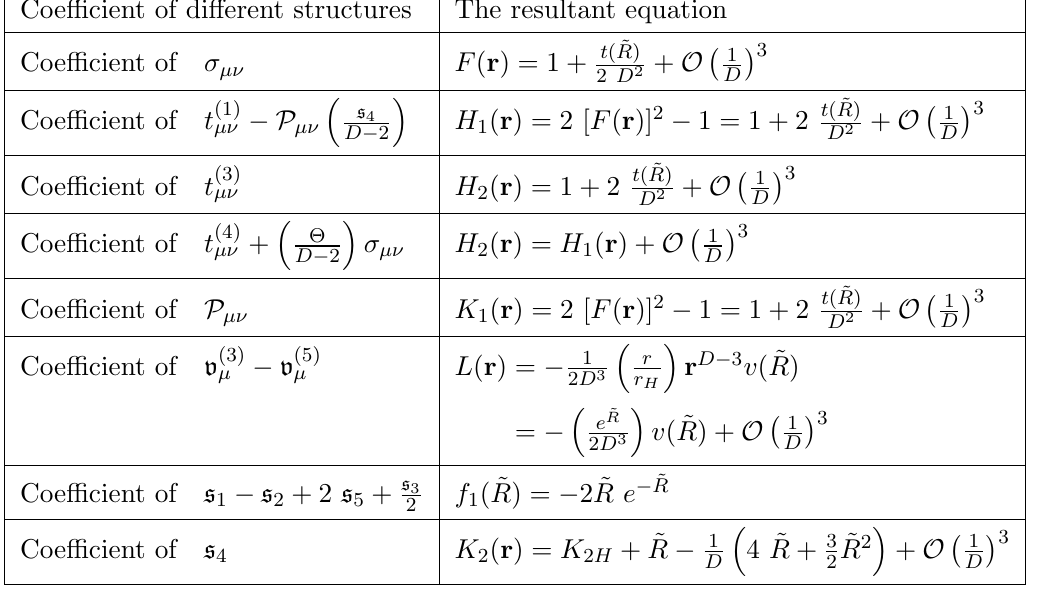
and W rest (cid:22)(cid:23) (cid:22)(cid:23)